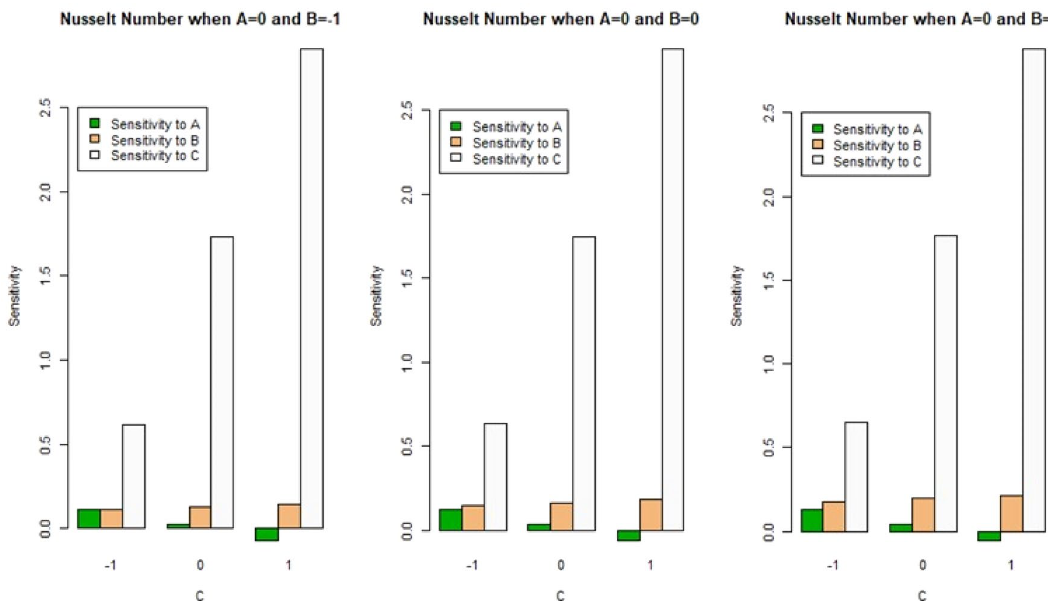
Figure 13. Bar chart representation of sensitivity analysis for Nu / √ Re x with A = 0 and all combinations of (B) and